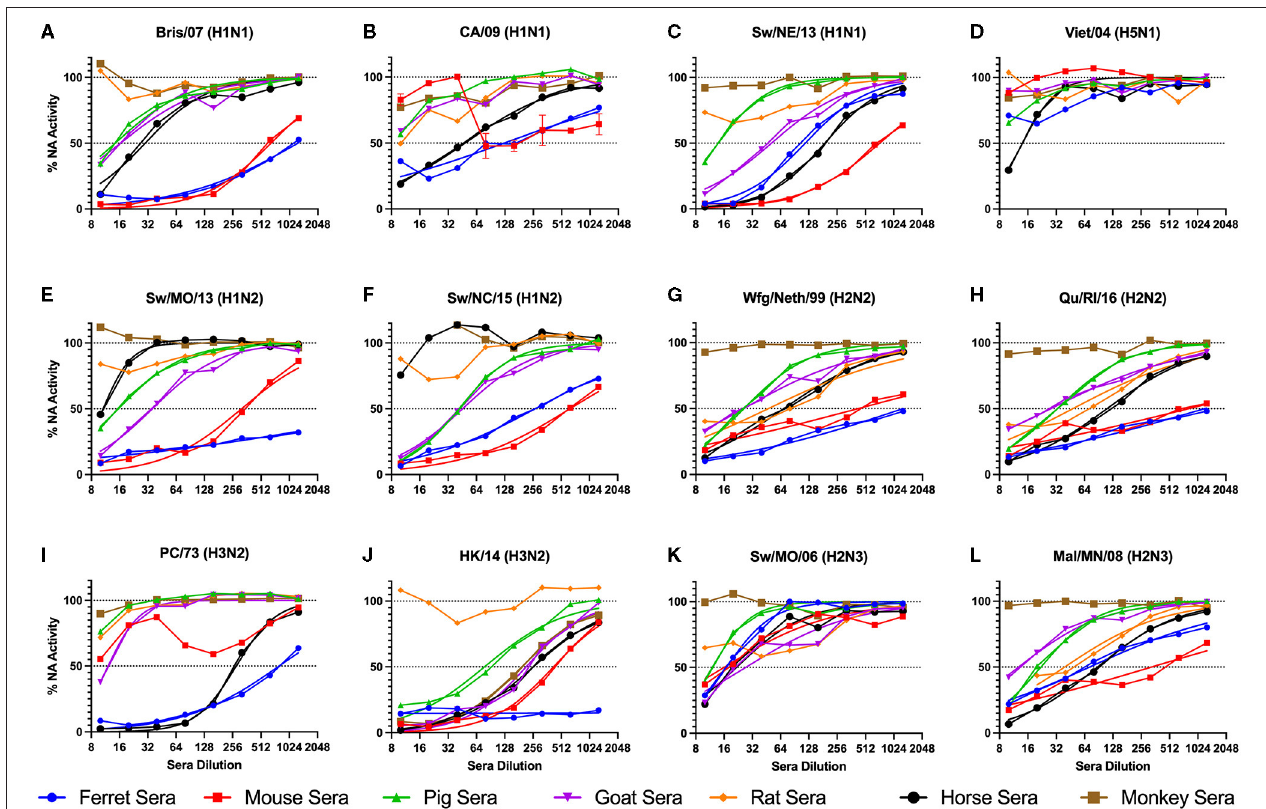
FIGURE 1 | NA inhibition of influenza virus with addition of raw animal sera. A panel of influenza viruses were tested including N1 (A-D) , N2 (E-J) , and N3 (K,L) NA subtypes. The sera were two-fold serially diluted from the reciprocal dilutions of 10-1,280. Non-linear regression was conducted, and the regression that resulted in estimable parameters (as indicated in Table 2 ) are shown. The NA activity was normalized to 100% of a “virus only with no sera” control.